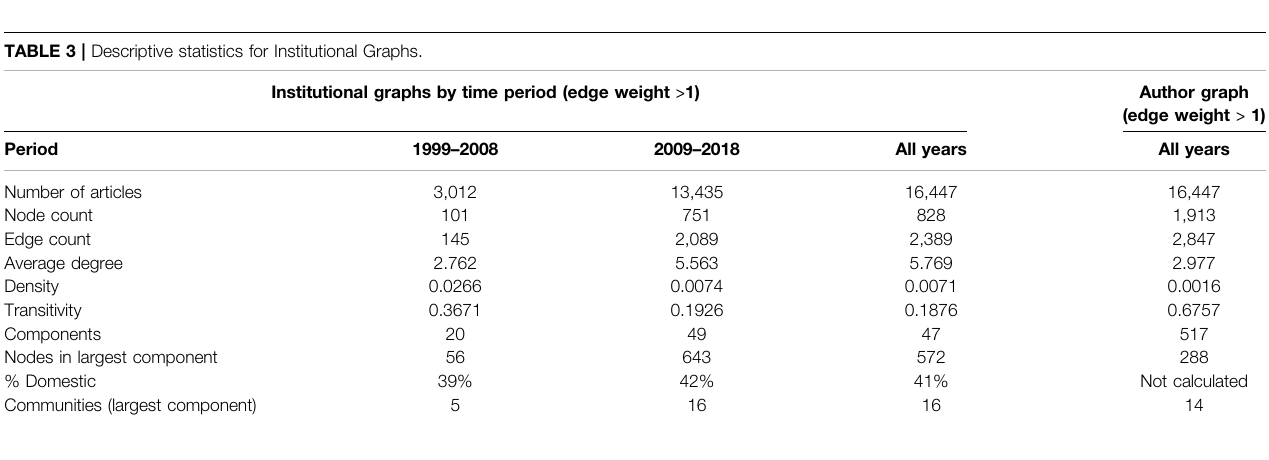
TABLE 3 | Descriptive statistics for Institutional